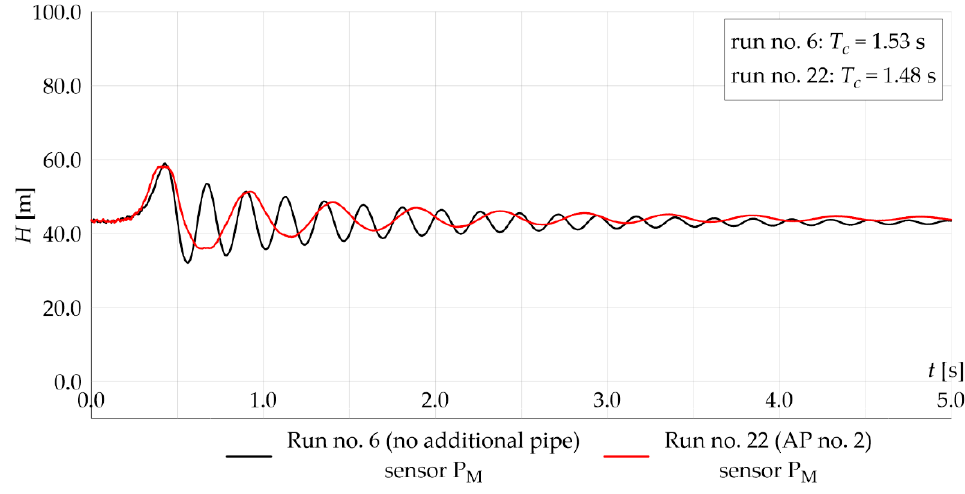
Figure 9. Pressure oscillations recorded during runs no. 6 and no. 22.